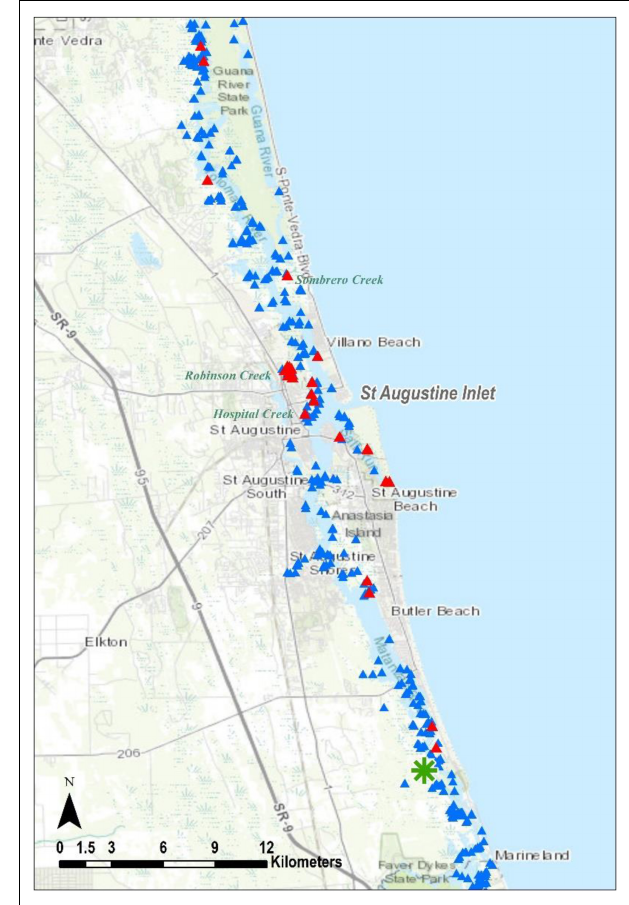
FIGURE 4 | The Duval Terrapin evidence. Triangles and asterisks as in Figures 2 , 3 , respectively. FIGURE 5 | The St. Johns Terrapin evidence. Triangles and asterisks as in